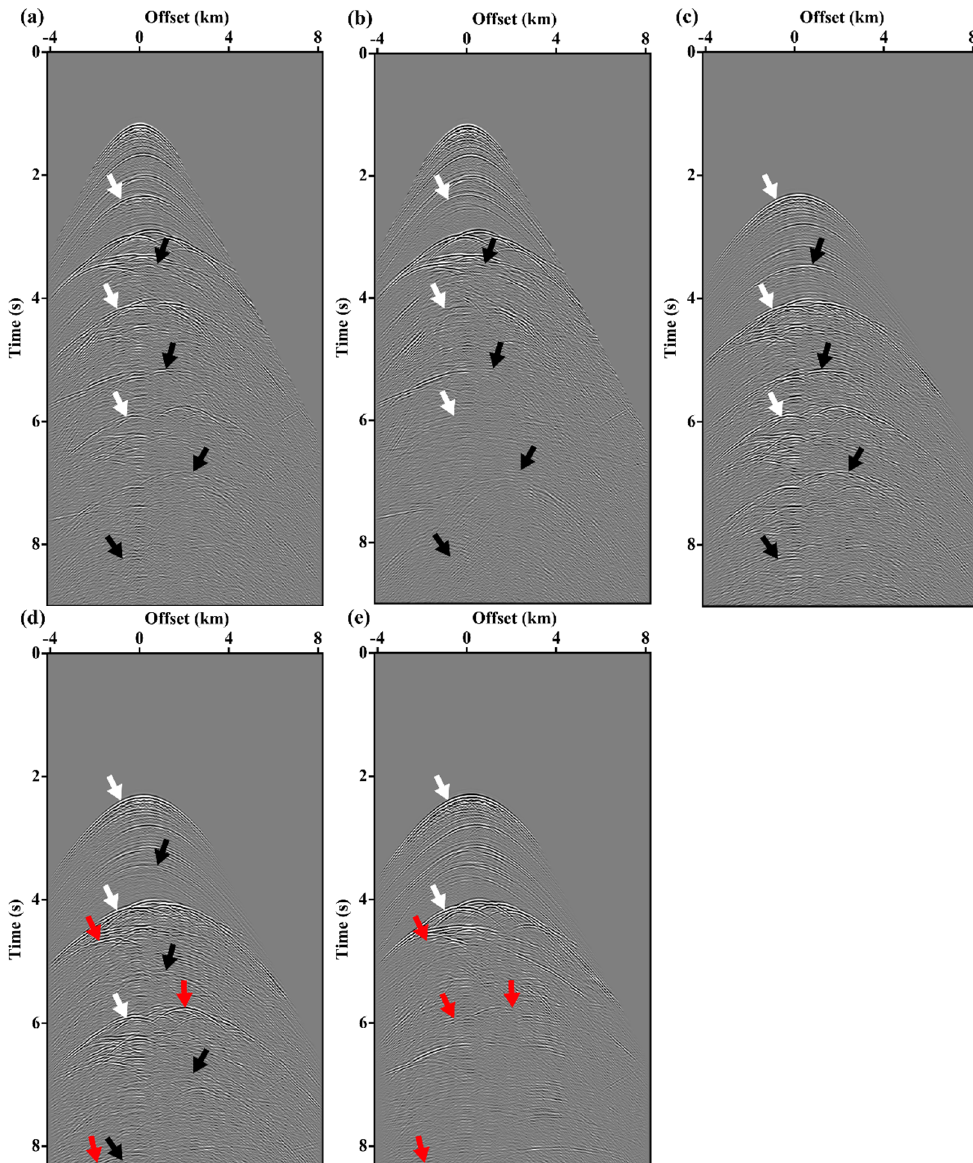
Figure 8. Multiples decomposition results for Pluto 1.5 model. ( a ) One original gather, ( b ) separated primaries, ( c ) all-order multiples, ( d ) first-order multiples, and ( e ) first-order water-bottom-related multiples. The white, black, and red arrows indicate the first-order multiples, higher-order multiples, and multiples unassociated with the water-column primaries, respectively.